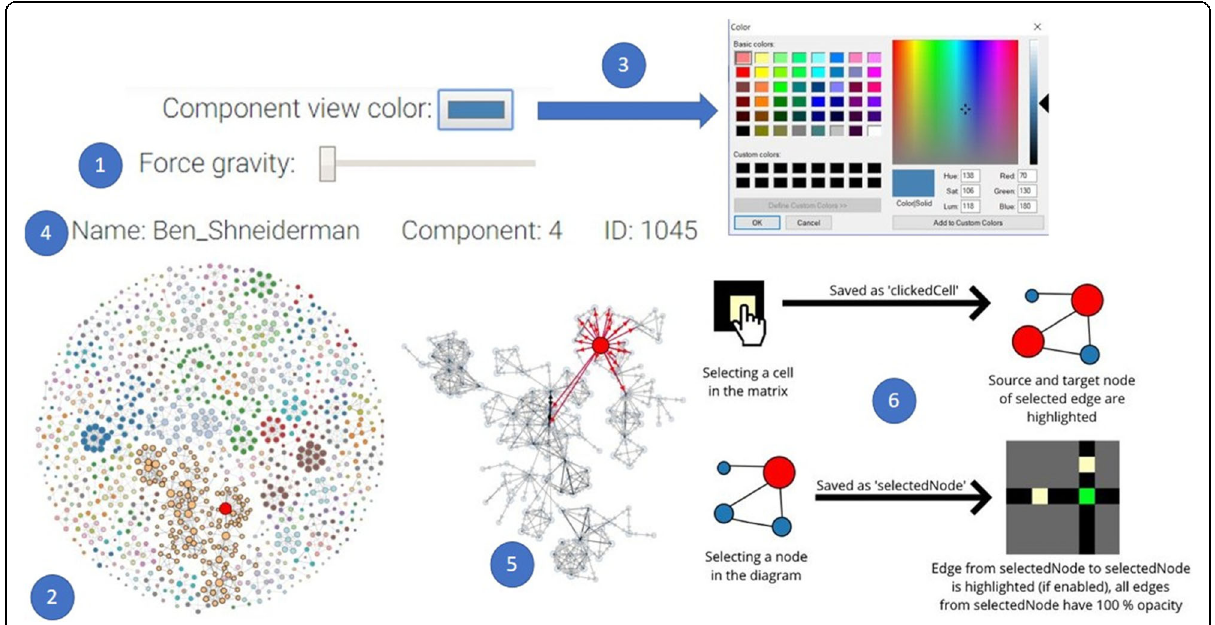
Fig. 8 An illustration of several interaction principles included in the tool: A layout or matrix reordering of a graph can be generated and the corresponding visualization can then be shown. Selecting a node and computing the cluster it belongs to is a powerful concept; however, the user can also manually select nodes and node groups for further